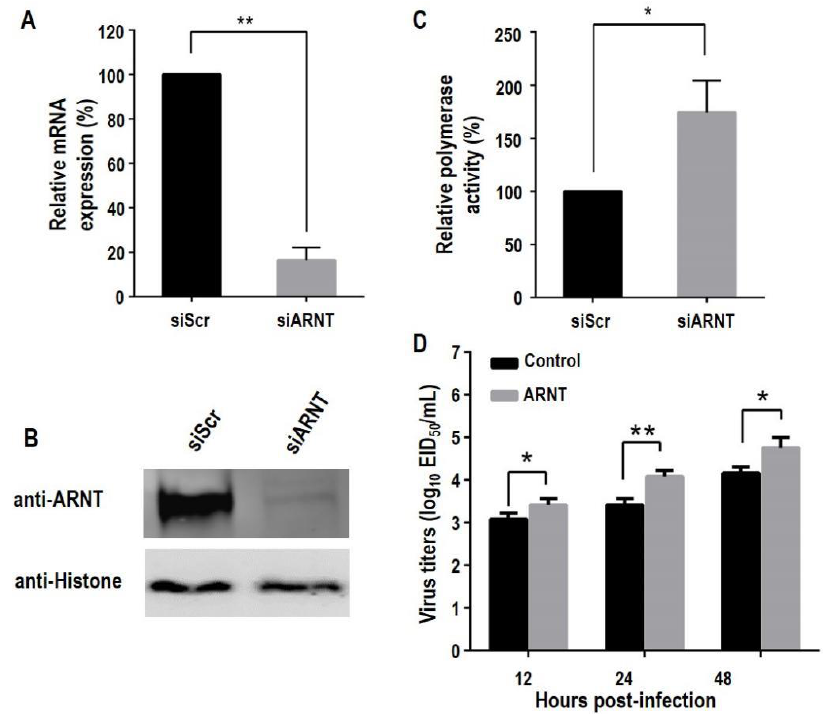
Figure 4. The polymerase activity and replication of influenza virus in HeLa cells with ARNT knockdown. Knockdown of ARNT in HeLa cells. HeLa cells were transfected with ARNT-specific siRNA (siARNT) and non-targeting siRNA (siScr) at a concentration of 100 nM. At 48 h p.t., the total RNA and nuclear proteins were extracted for qRT-PCR ( A ) and Western blotting ( B ) to evaluate the ARNT knockdown efficiency. ( C ) The effect of ARNT knockdown on the polymerase activity of H5N1 influenza A virus. Four RNP-expressing plasmids along with the Firefly and Renilla luciferase-expressing plasmids (pPolI-T-Luc and pRL-TK) were co-transfected into HeLa cells pretreated with either siARNT or siScr. ( D ) The effect of ARNT knockdown on the replication of H5N1 influenza A virus. HeLa cells, transfected with siARNT or siScr for 48 h, were infected with GS/65 at an MOI of 0.1. Cell supernatants were collected at 12, 24, and 48 h p.i. and titrated in eggs. * p < 0.05; ** p < 0.01.